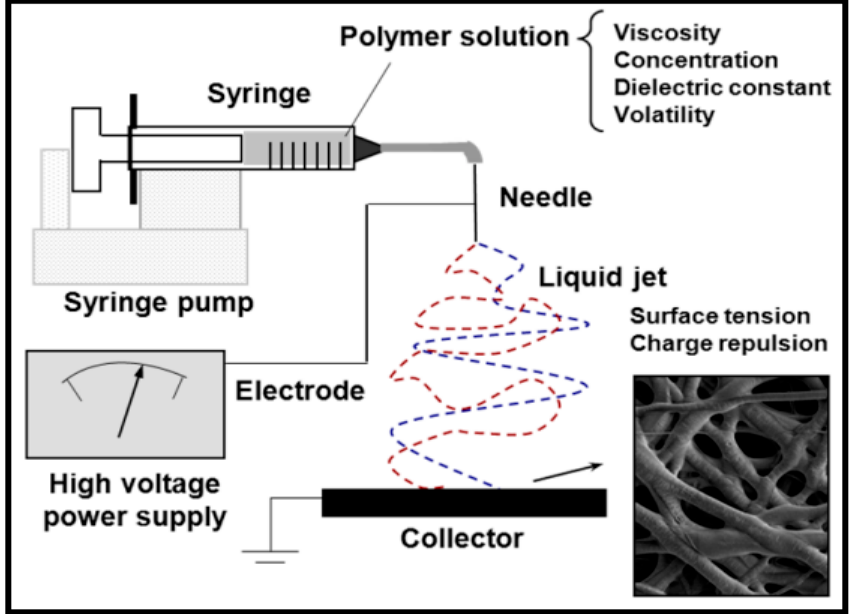
Figure 11. Schematic diagram showing the main parts of typical electrospinning equipment. Reproduced with permission from [170].